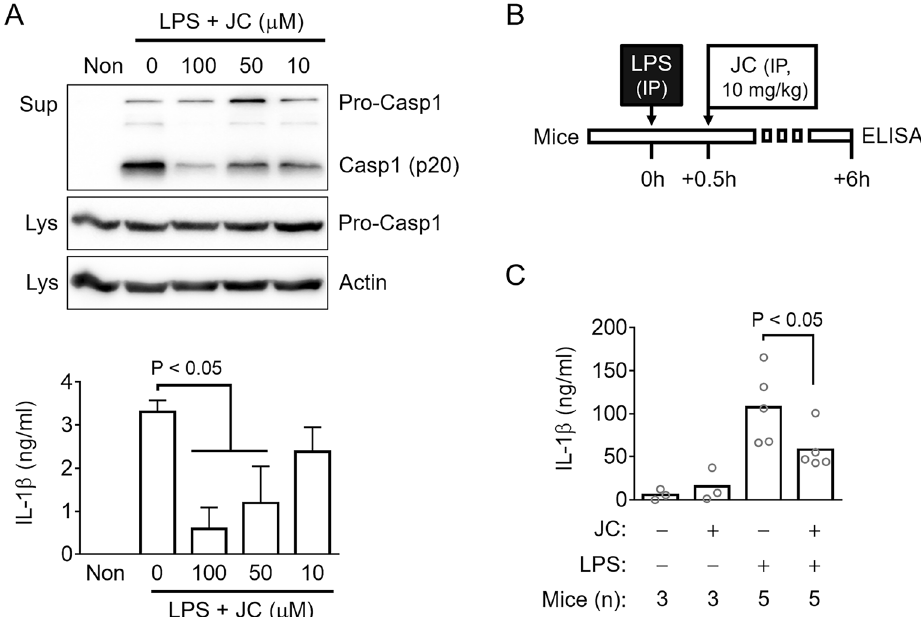
Figure 3. Effects of JC on NC inflammasome and LPS injected mice. ( A ) LPS-primed BMDMs were transfected with LPS and treated with JC. The cleavage of caspase-1 was analyzed by immunoblotting, and the release of IL-1β was detected by ELISA. The bar graph presents the mean ± SD with at least three independent experiments. ( B ) Schematic diagram of the experimental process. The mice were injected intraperitoneally (IP) with LPS and JC at the indicated times. A peritoneal lavage was collected to measure IL-1β secretion 6 h after the LPS injection. ( C ) The peritoneal IL-1β secretion was measured by ELISA. The dot indicated the value of each